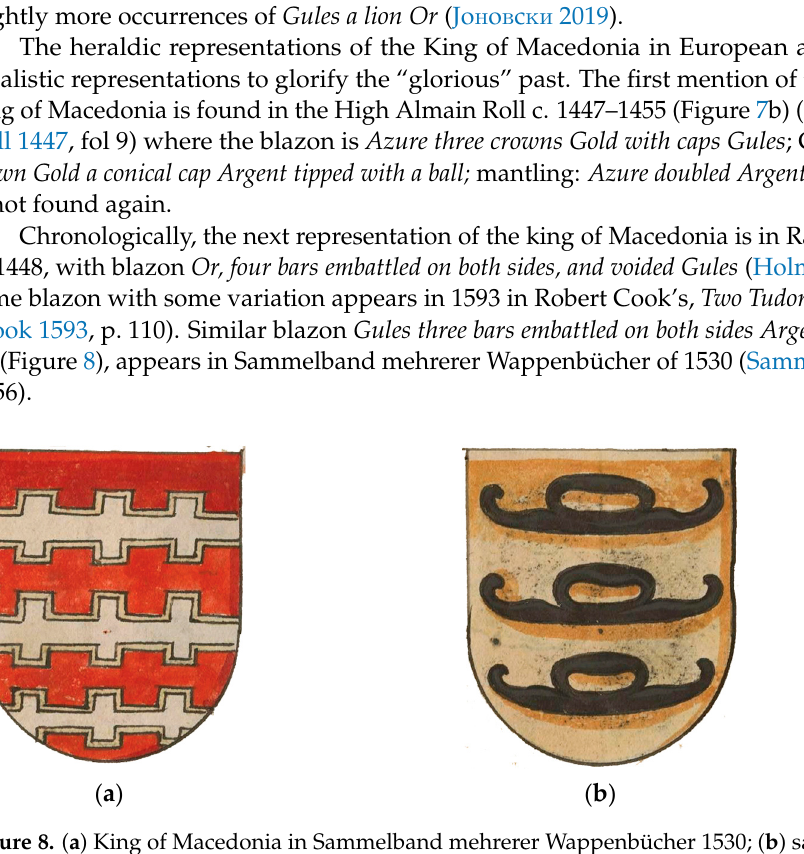
Figure 8. ( a ) King of Macedonia in Sammelband mehrerer Wappenbücher 1530; ( b ) same. The most frequent blazon is with three crowns in a two-colour combination. Argent